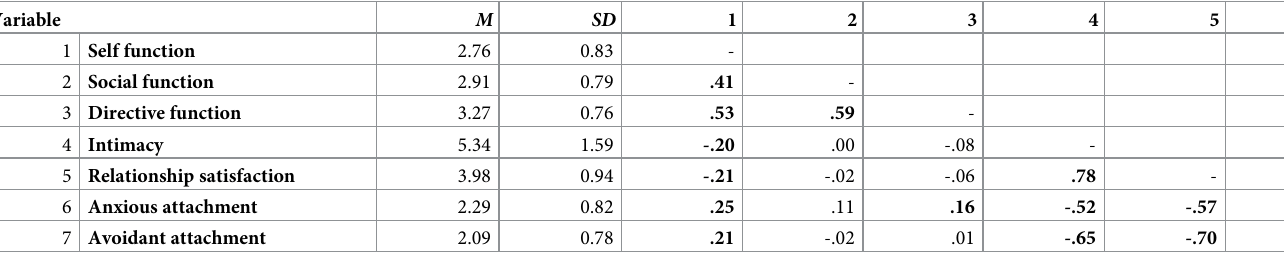
Table 2. Descriptive statistics and correlations among the study variables in Study